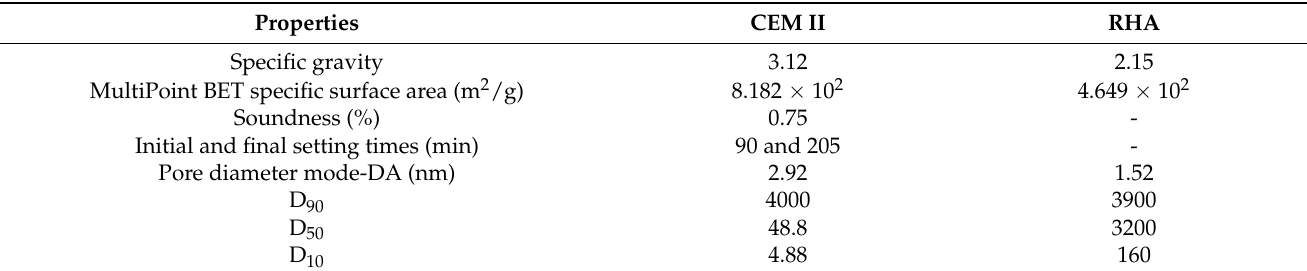
Table 4. Chemical composition of CEM II and RHA. (Nduka et al., 2021)